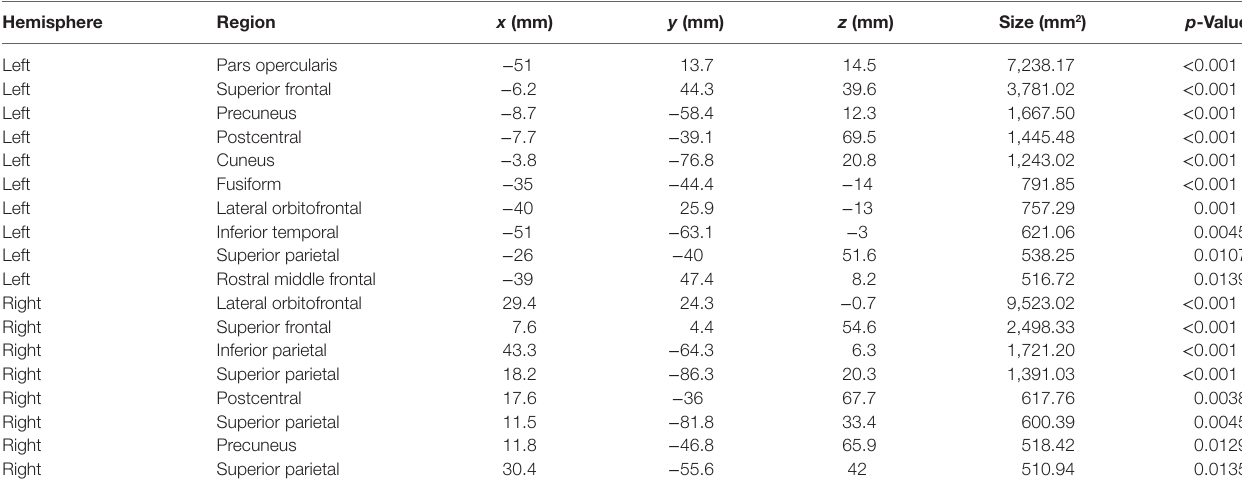
TaBle 2 | Age-related decrease of cortical thickness.